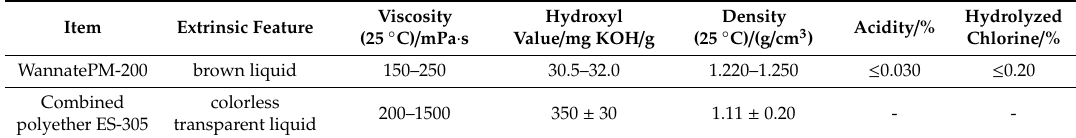
Table 1. The physicochemical property of the polyurethane component.